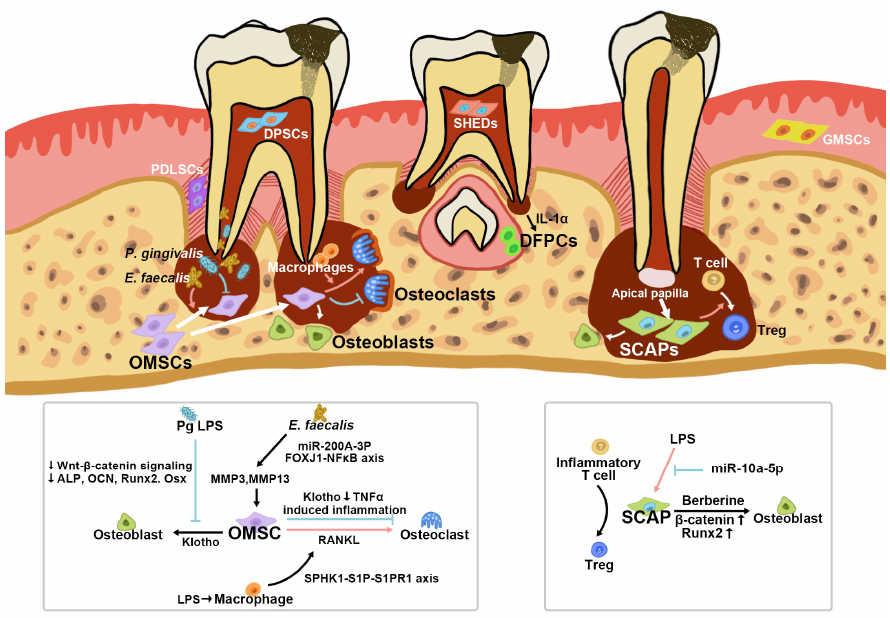
Figure 2. The regulatory networks of OMSCs, DFPCs and SCAPs within apical